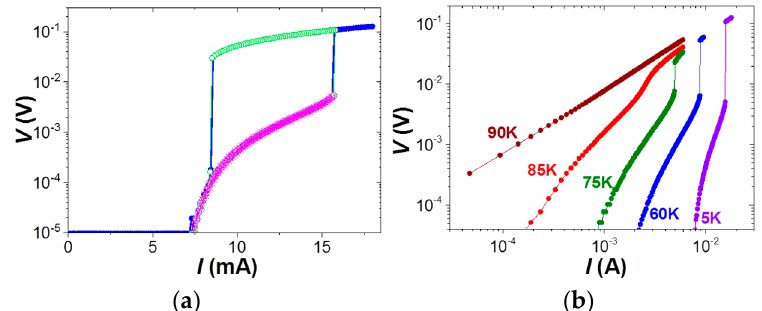
Figure 3. ( a ) I-V characteristics measured at 5 K and 1 T on a 300-nm-wide nanowire for a maximum applied current I max = 18 mA (closed blue circles), 16 mA (open green circles), and 15.8 mA (magenta stars). ( b ) I - V curves measured at 1 T for a 300-nm-wide nanowire at different temperatures.